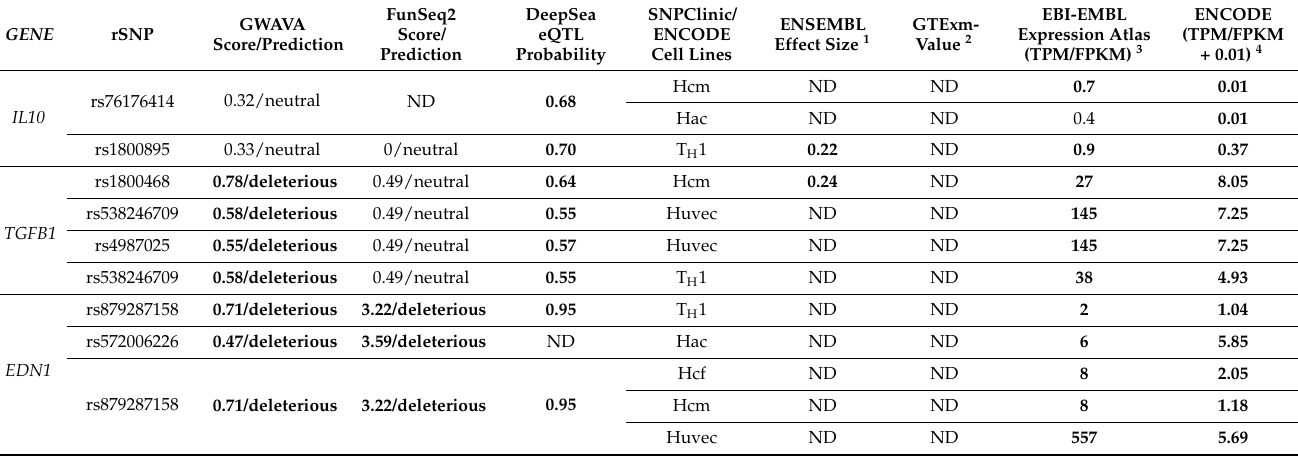
Table 3. Functional confirmation of putative rSNPs in other databases, first the classification of variants was carried out using the tools GWAVA and Funseq2, secondly, a score was obtained in DeepSea, for each SNP the probability of contributing to the expression as eQTL was found. Finally, the effect of each SNP on tissue-dependent expression was obtained in the ENSEMBL, GTEx, EBI- EMBL and ENCODE databases. Confirmed true rSNPs (firstly predicted by SNPclinic v.1.0) are shown in bold